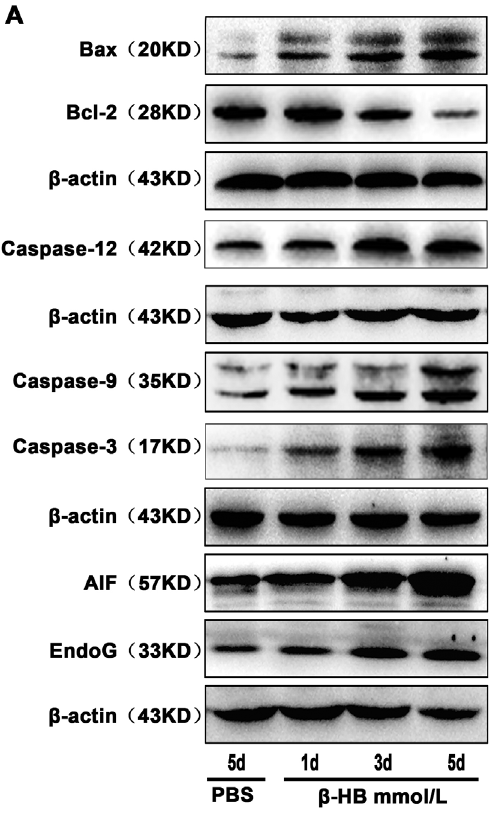
Figure 9. Effects of b -HB on the expression of apoptosis proteins invivo . Mice were intraperitoneally given b -HB or PBS (control). Cleaved caspase-12, - 9, - 3, Bax, Bcl-2, AIF and EndoG protein were detected by Western